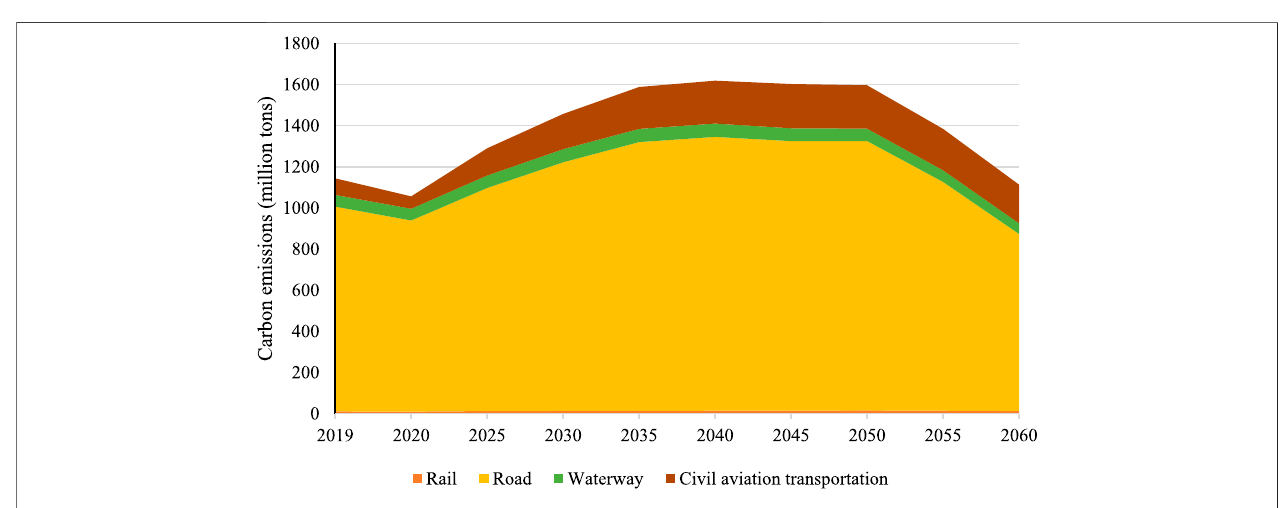
FIGURE 6 | The carbon emissions of transportation under Baseline